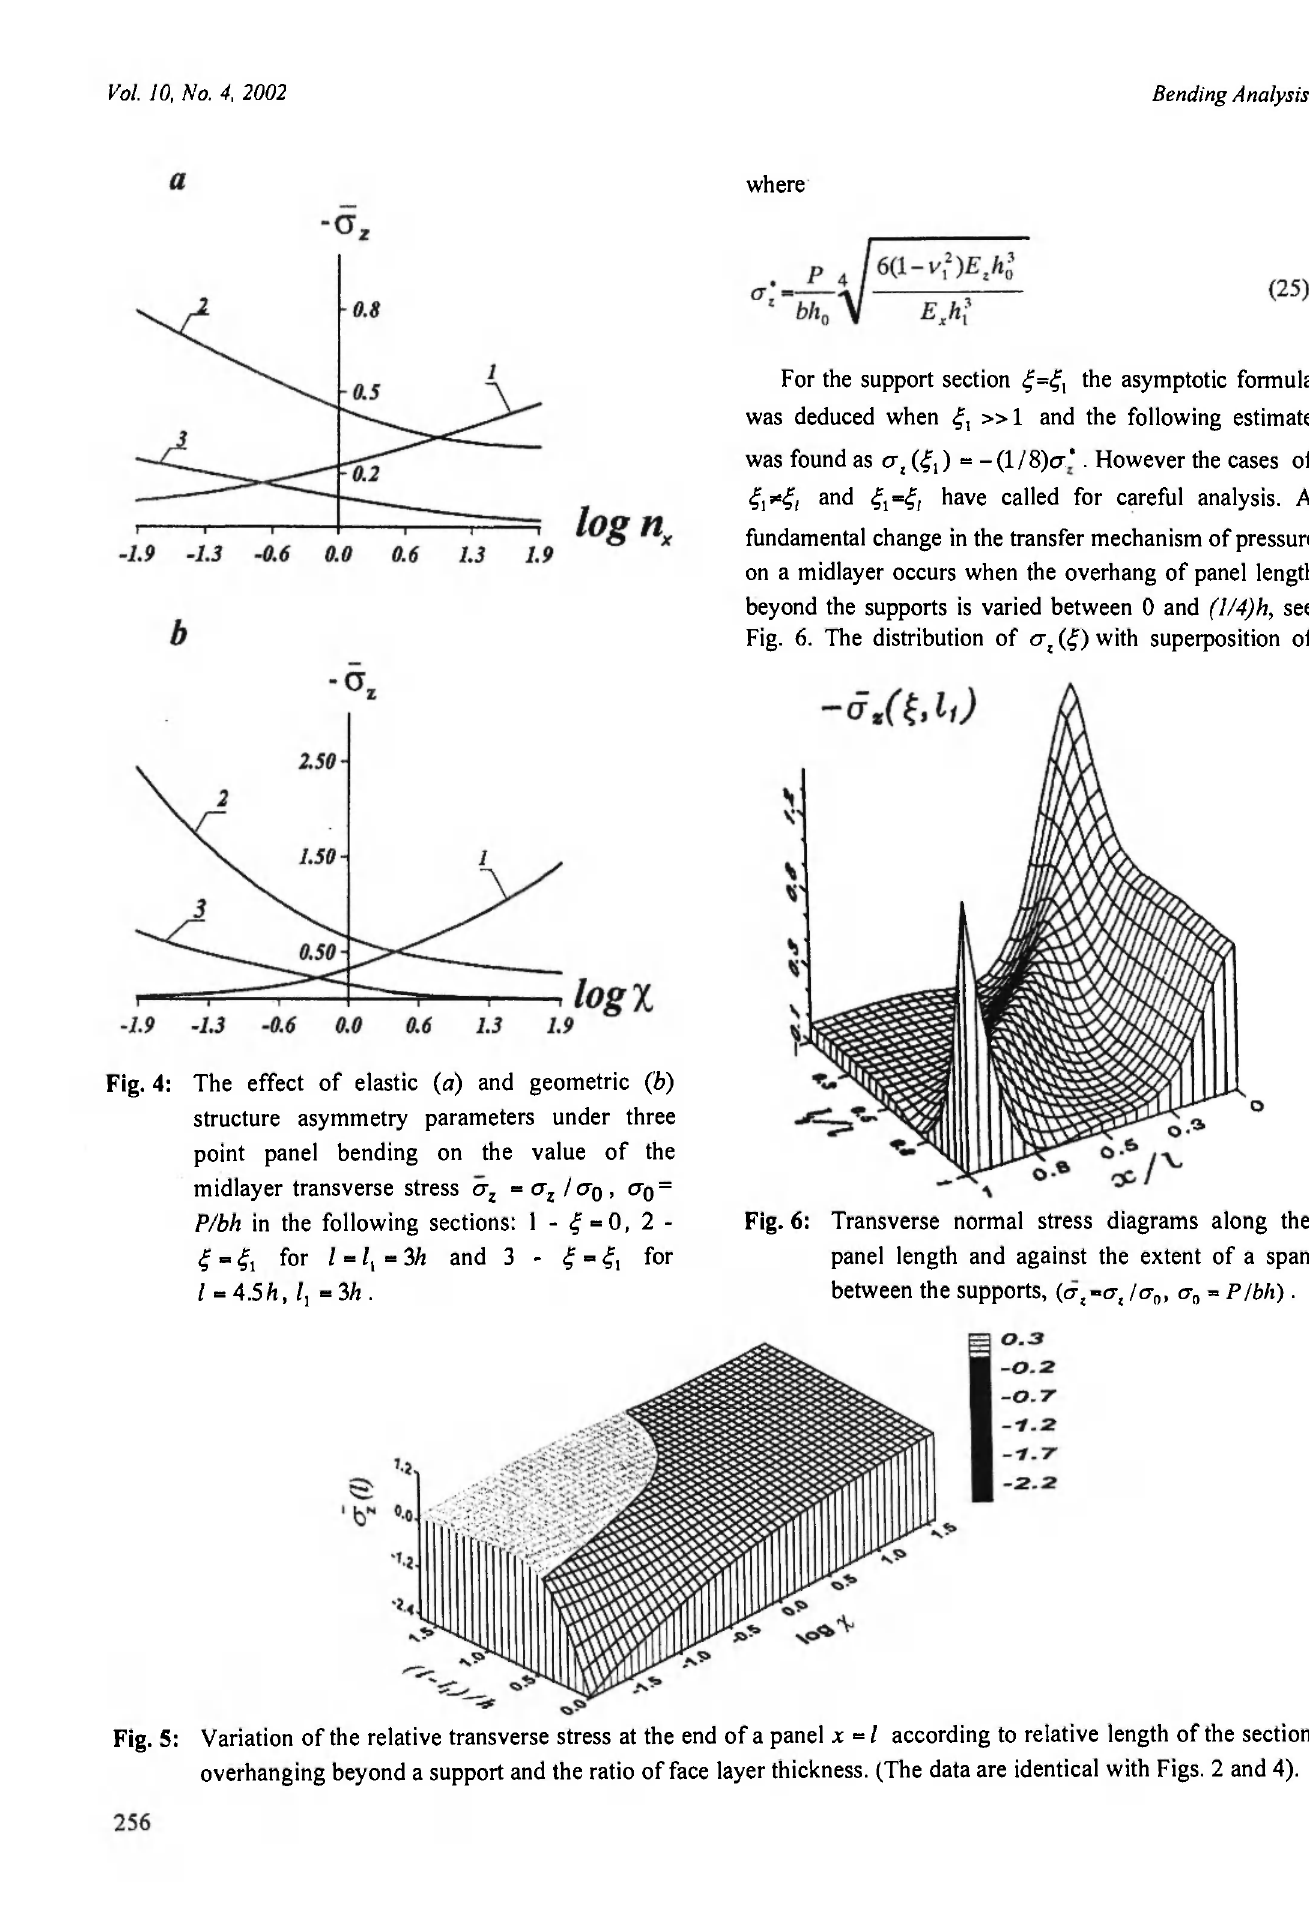
Fig. 6. The distribution of σ ζ (ξ) with superposition of